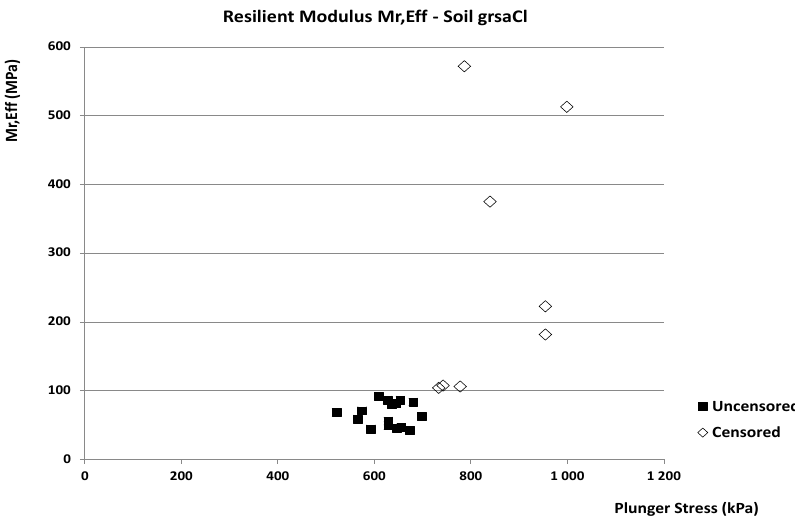
Figure 8. Resilient modulus M r,eff for soil grsaCl.